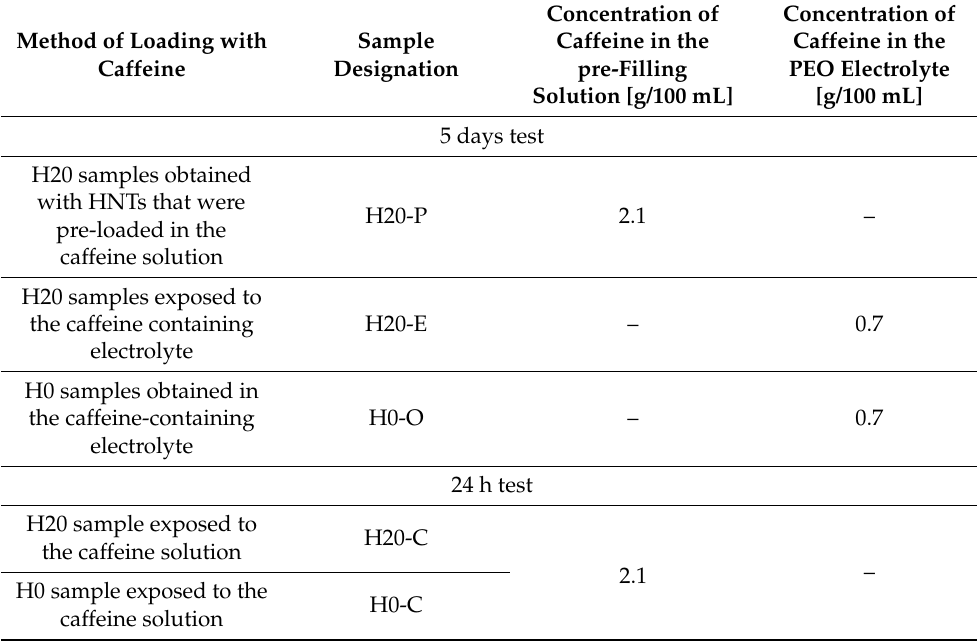
Table 10. Designations of the samples for the release behavior studies. Method of Loading with Caffeine